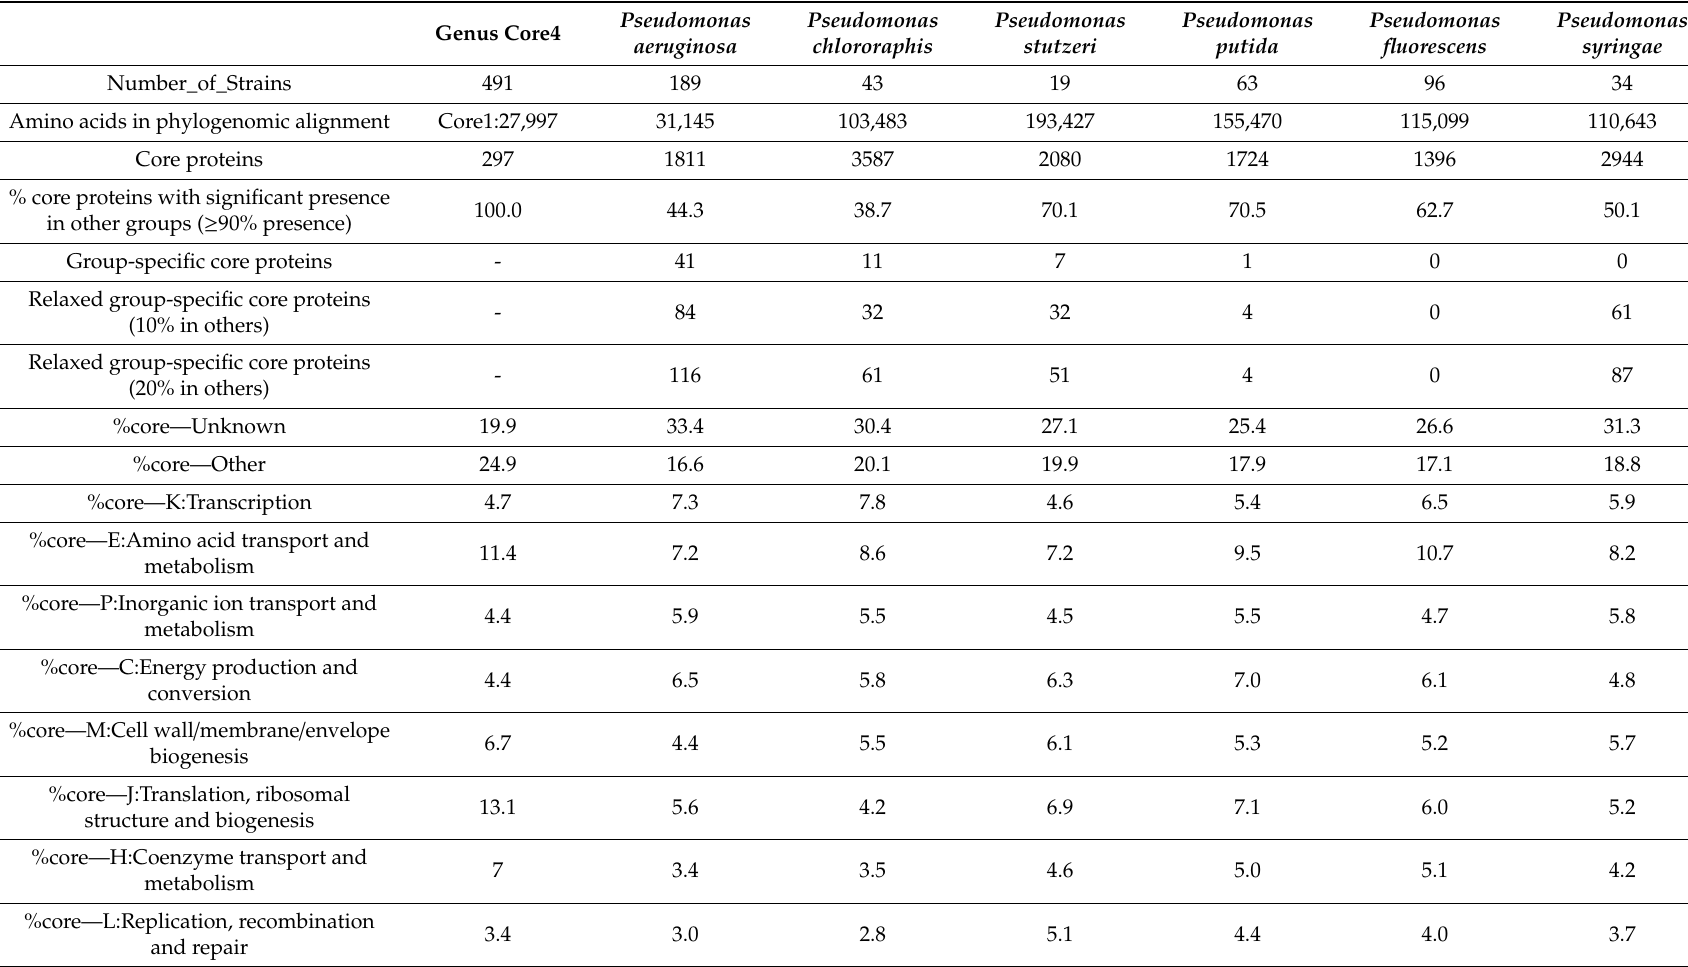
Table 1. Summary table of the core proteomes and their functional categories for the Pseudomonas genus and the six evolutionary groups. Note that, for the phylogenomic analysis of the entire genus (core4), we used the alignment produced by core1, that also includes 3 outgroups.